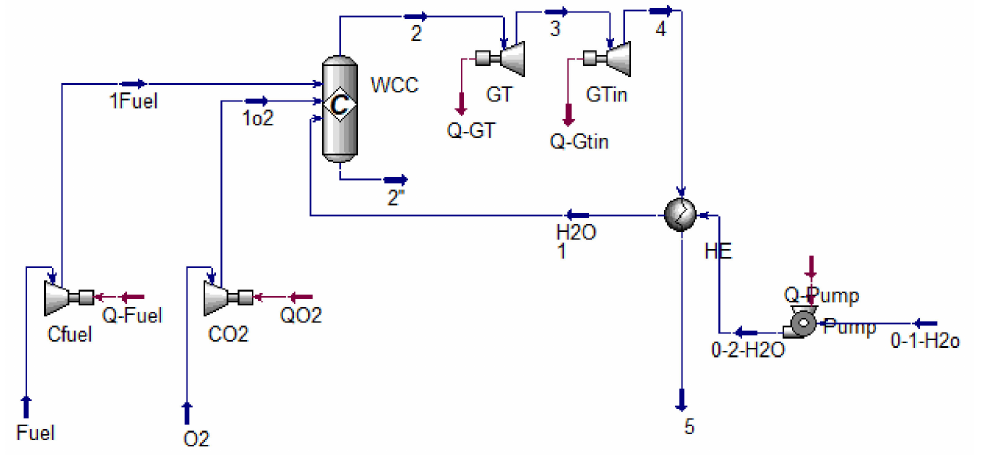
Figure 2. Simulation of PFD0 by Aspen Hysys (0FUEL, 0O 2 , 01-H 2 O, 02-H 2 O, 1FUEL, 1O 2 , 1H 2 O, 2, 3, 4, 5—cycle nodal